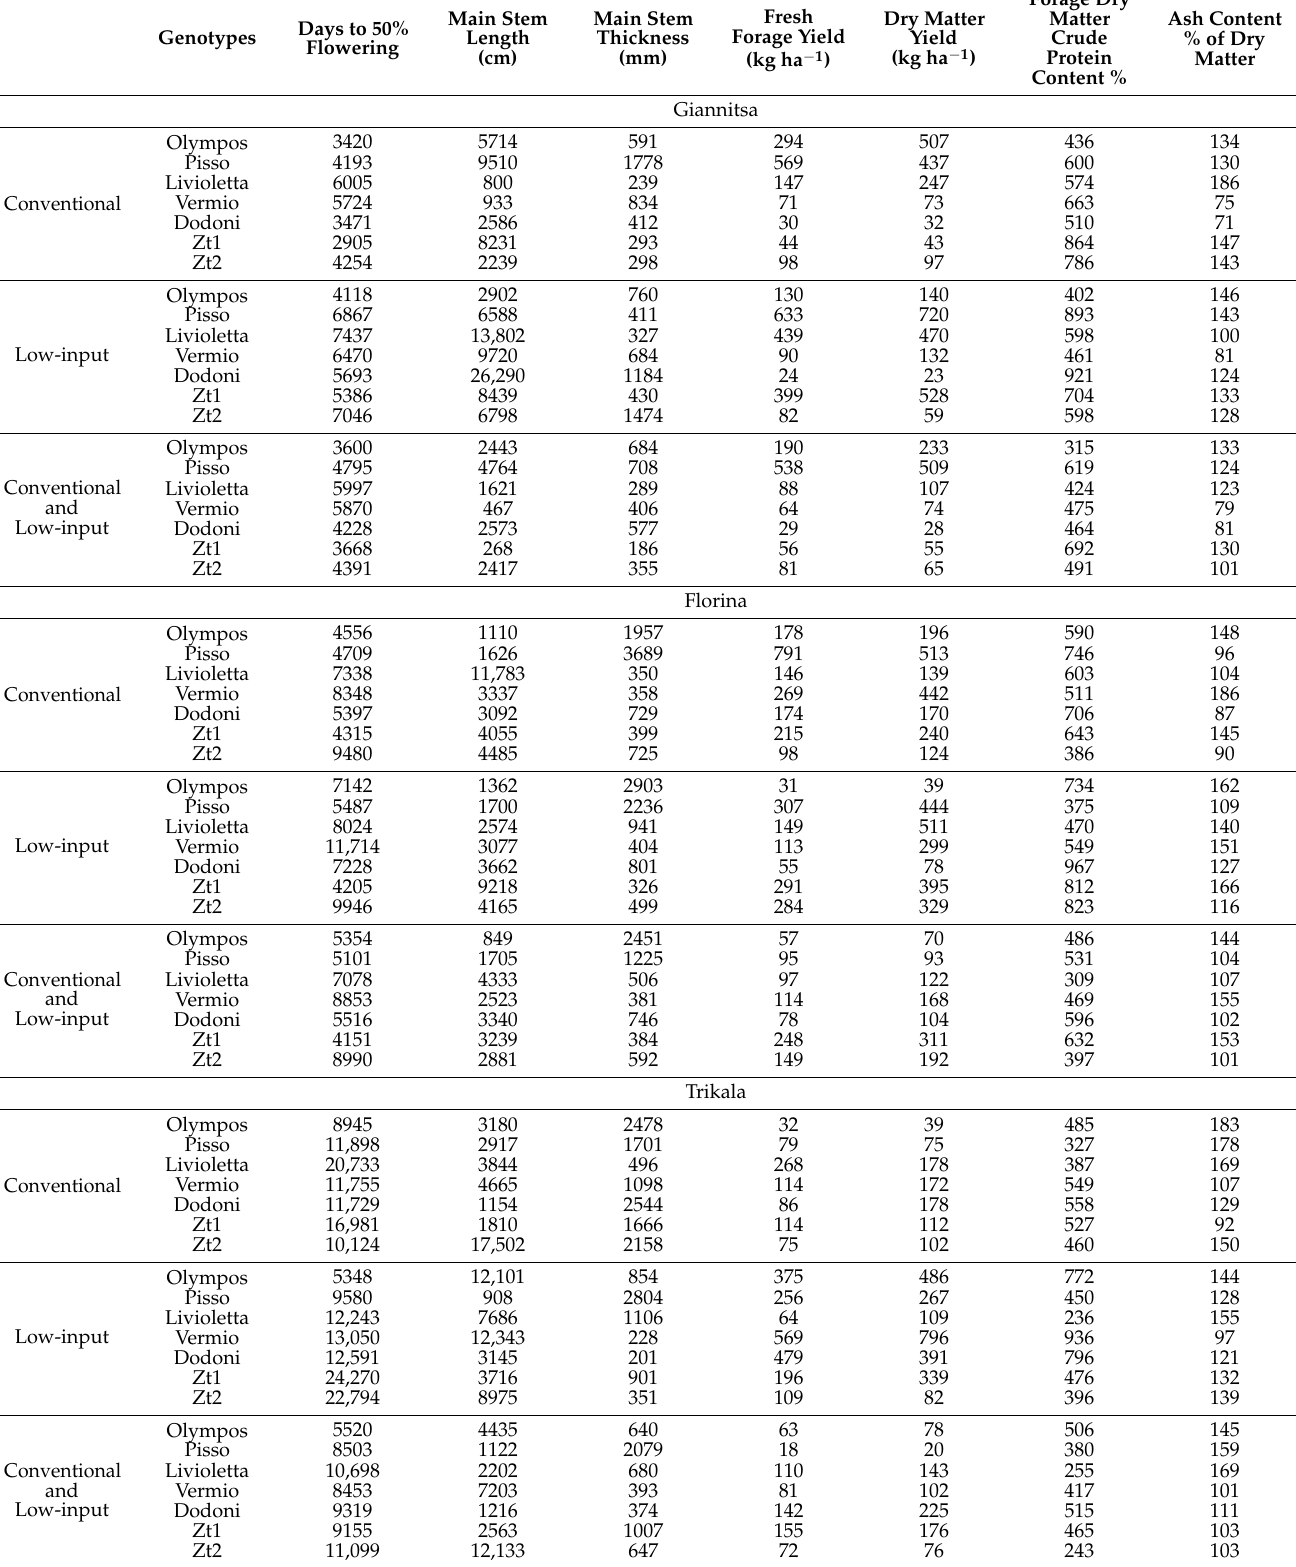
Table 4. Combined trait stability index across genotypes and environments for the two farming systems: days to 50% flowering, main stem length (cm), main stem thickness (mm), fresh forage yield (kg ha − 1